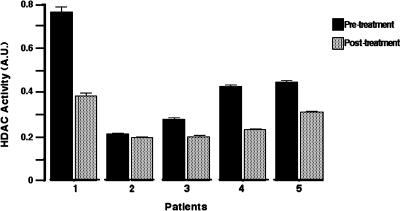
Histone deacetylase activity.The five patients assayed showed a reduction in enzymatic activity. In Y axis are the absolute values in optical density (OD) units. Higher and lower decreases were 0.3845 and 0.0175, for a mean decrease of 0.1624. This difference was statistically significant (p = 0.042).